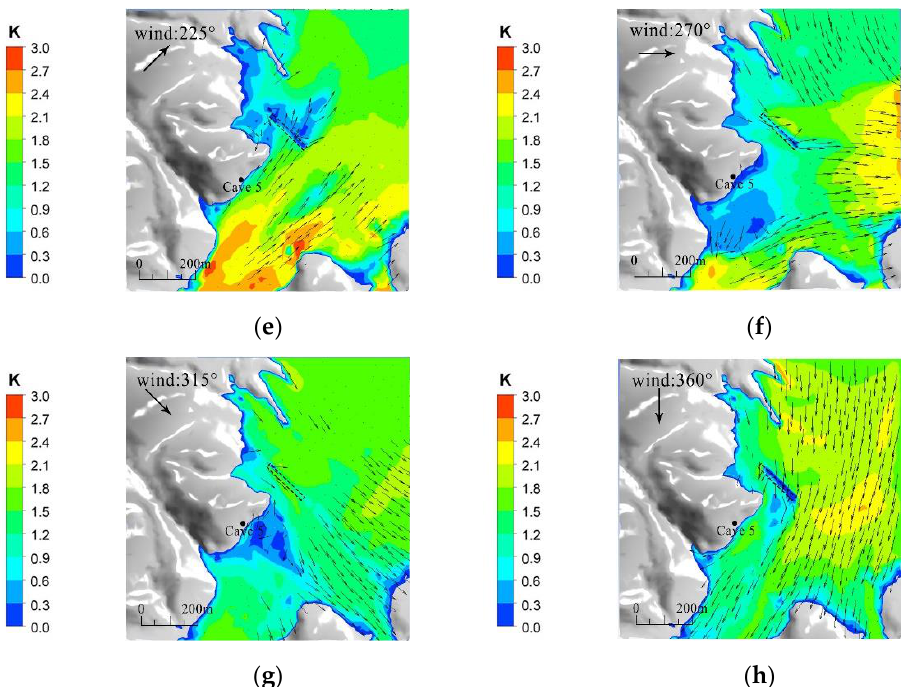
Figure 18. Contours of the simulated wind speed ratio in a horizontal plane at Cave 5 height with the influence of shelterbelt for the inlet wind directions of 45° – 360°. The rectangular in black line represents the position of shelterbelt. ( a ) 45°; ( b ) 90°; ( c ) 135°; ( d ) 180°;( e ) 225°; ( f ) 270°; ( g ) 315°; ( h ) 360°.